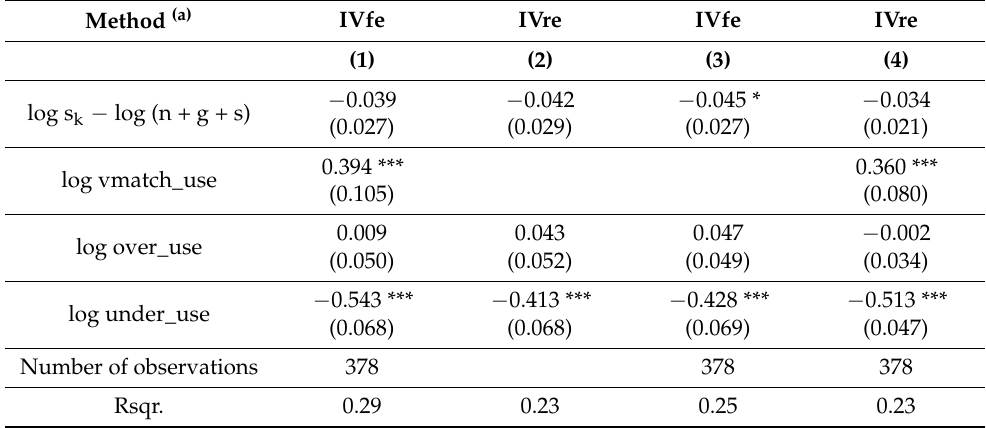
Table 4. Effect of vertical (mis)match of employees with upper secondary education on per capita